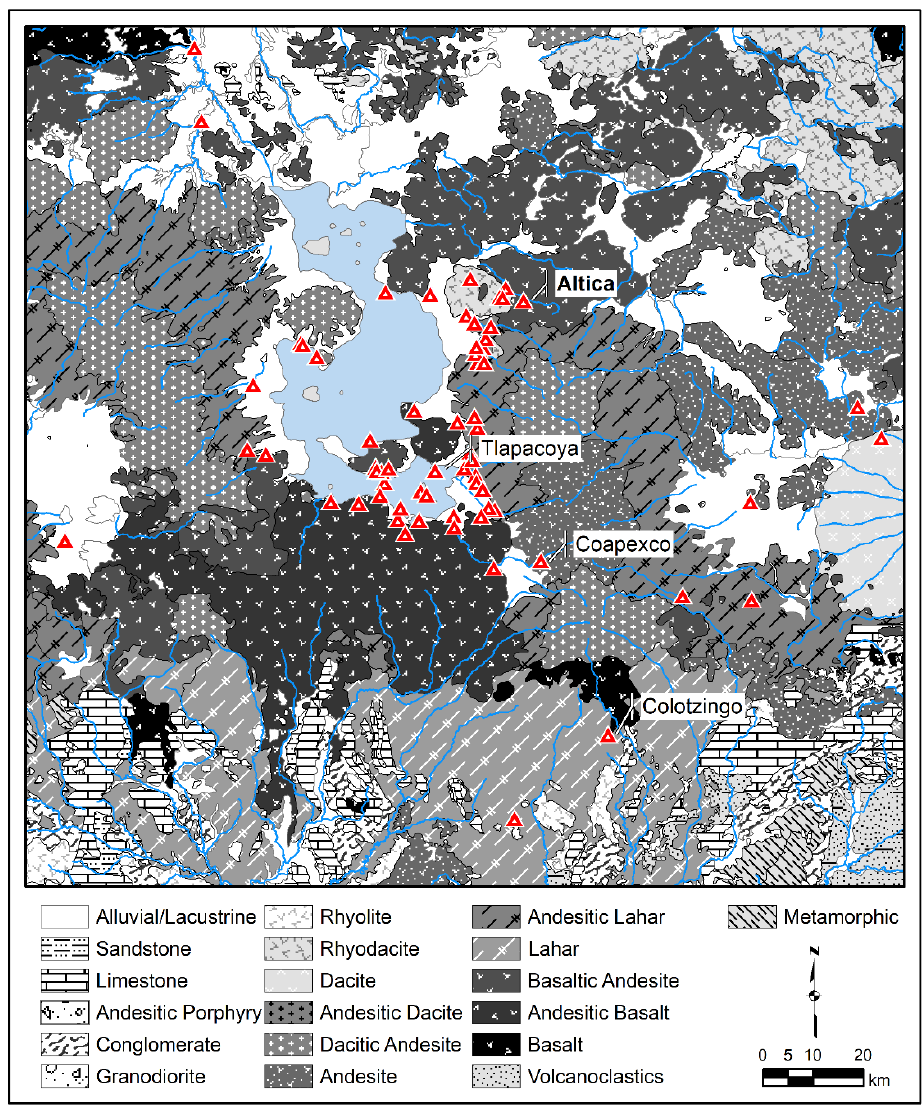
Figure 1. The Basin of Mexico geology and sites of pottery sampling.